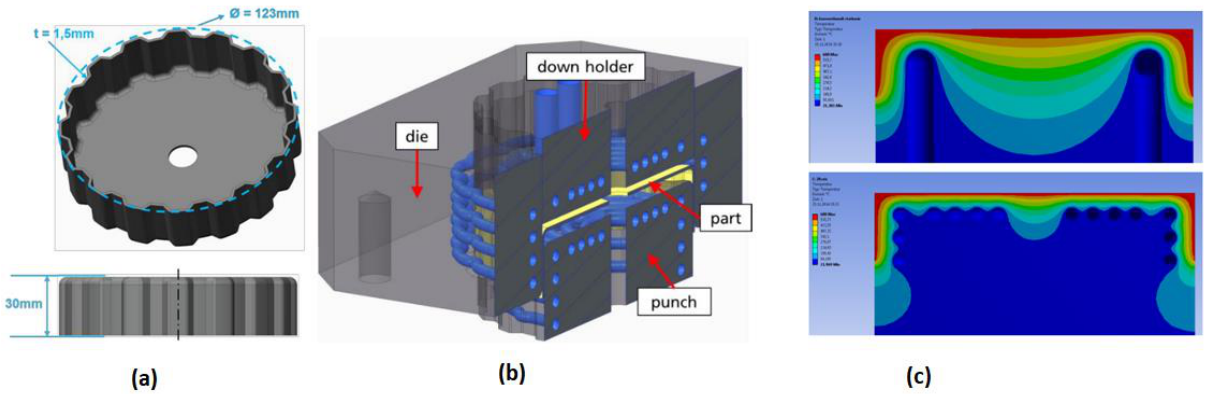
Figure 4. ( a ) Gear pan component; ( b ) gear pan tool system with adoptive cooling channels; ( c ) temperature map of conventional tool ( top ) and additively manufactured tool with adoptive cooling channels ( bottom ), reproduced from [32], with the permission from iCAT, 2016.